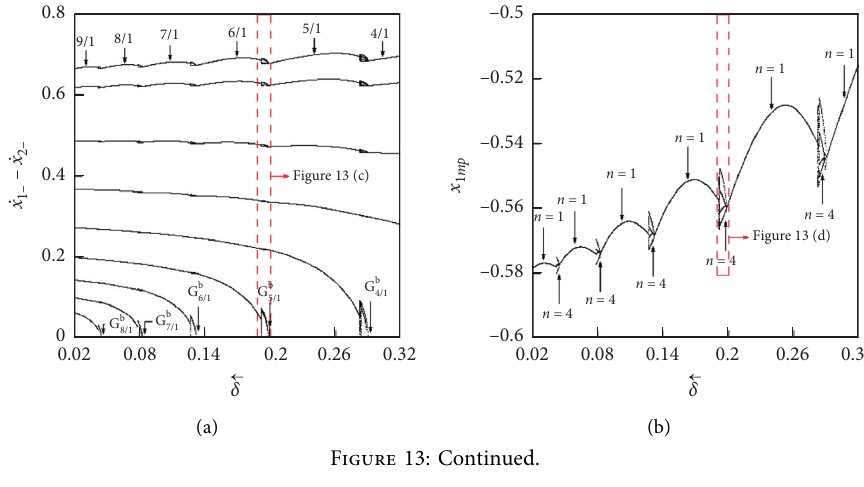
Figure 12: Bifurcation diagrams that cross the tongue-like region TR (b) periodic bifurcation diagram.